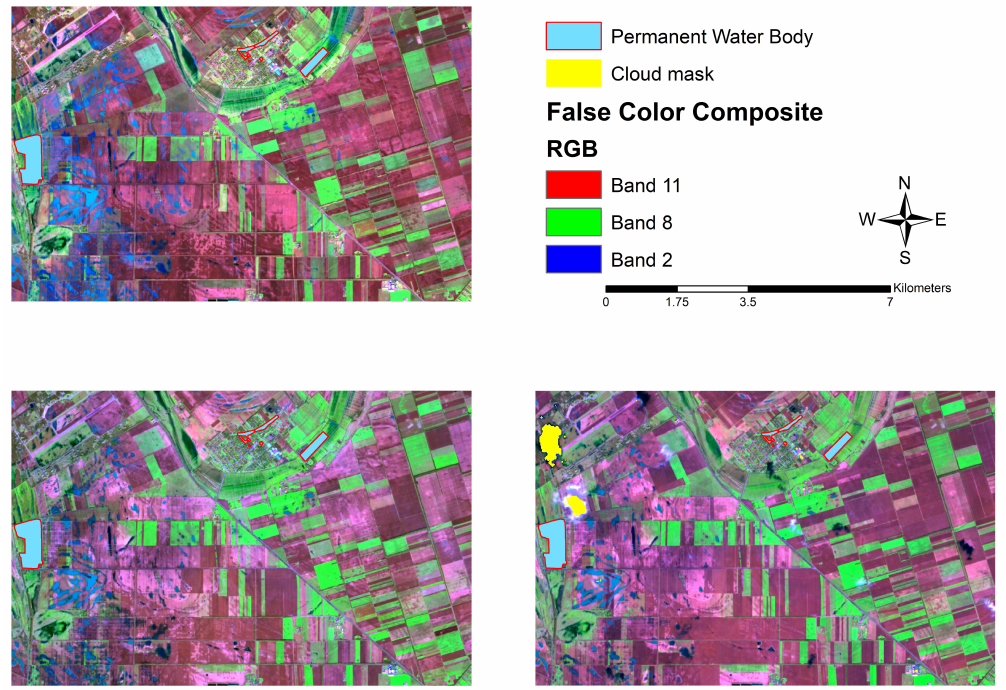
Figure 3. Sentinel-2 false-color composite of the study area with permanent water bodies and cloud masks at three dates (23 February 2021 ( upper left ); 7 March 2021 ( lower left ); and 20 March 2021 ( lower right )).